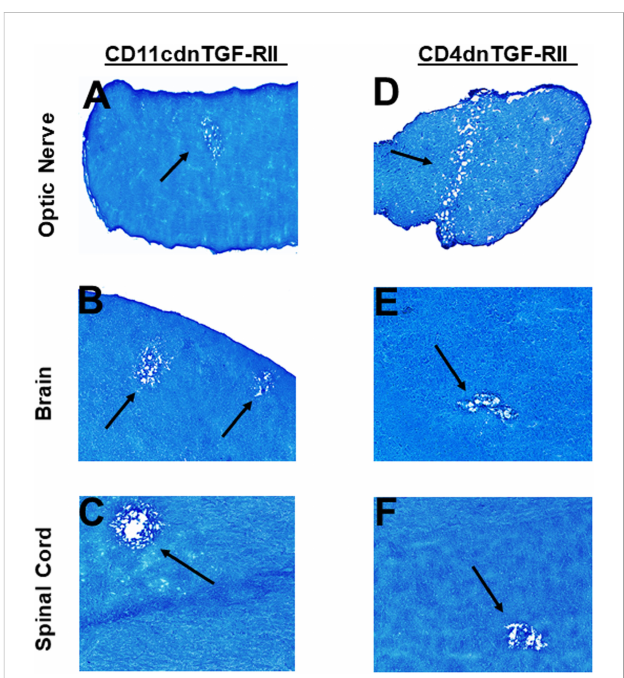
FIGURE 7 Role of TGF b in HSV-IL-2 induced CNS demyelination. Five female CD11cdnTGF-RII (A, B, C) and CD4dnTGF-RII (D, E, F) mice were infected ocularly with 2 X10 5 pfu/eye of HSV-IL-2 virus. On day 14 PI, optic nerves (A, D) , brain (B, E) , and spinal cord (C, F) were collected, fi xed, sectioned, and stained with LFB. Representative photomicrographs are shown. Arrows indicate areas of demyelination. x10 objective lens was used (100x